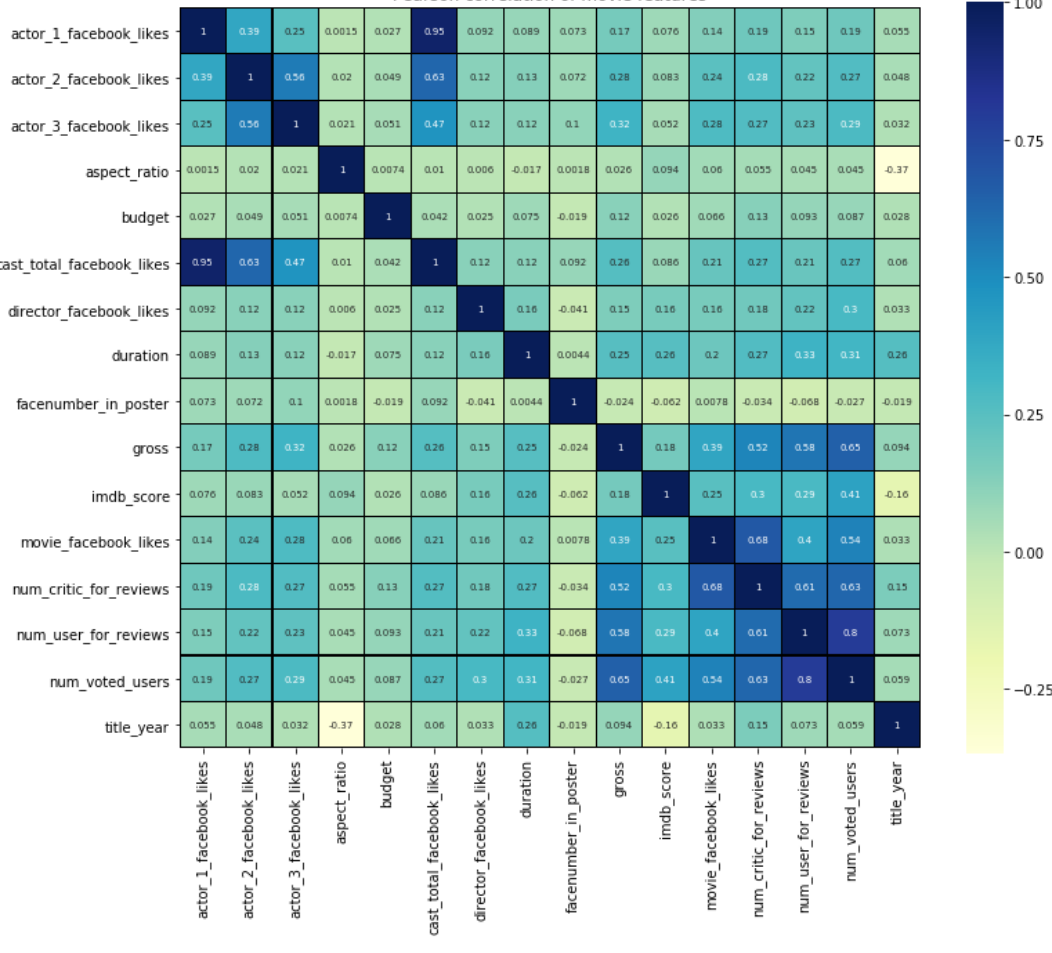
Figure 1. Pearson correlation plot for movie